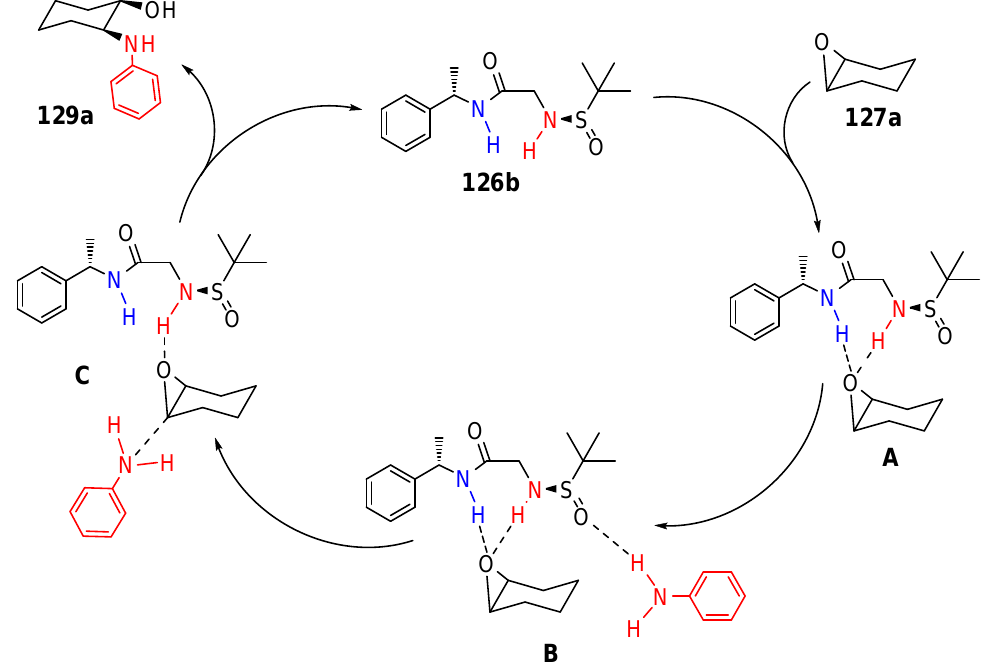
Scheme 39. Probable catalytic cycle for epoxide ring opening